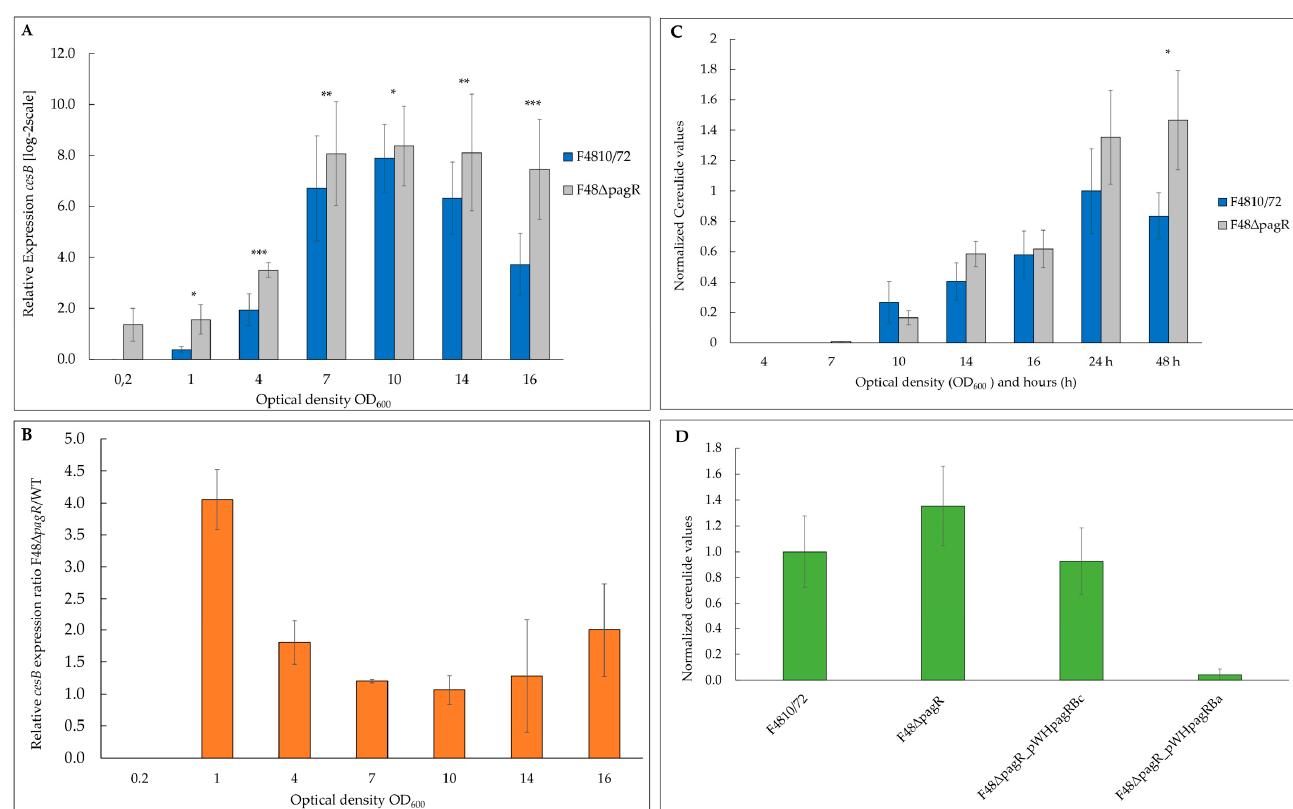
Figure 6. PagRBc represses cereulide toxin synthesis. The emetic reference strain B. cereus F4810/72 (wt) and its isogenic F48 ∆ pagR mutant were grown in LB broth at 30 °C. Total RNA was extracted from B. cereus F4810/72 and F48 ∆ pagR , harvested at indicated optical densities. Gene expression of ces and amounts of the cereulide toxin was determined at the OD 600 as indicated. ( A ) The kinetics of ces transcription in F48 ∆ pagR and its wild-type parent were determined by qRT-PCR. Levels of ces expression were determined by qRT-PCR and normalized to 16S rrn levels of the same sample preparations. The expression level of ces gene obtained for the wild-type strain at an OD 600 of 0.2 (external calibrator sample) was set to 1 (R = 1) by default, and all other expression levels were compared relative to this condition using the REST method [41]. Data were calculated from at least two independent qPCR measurements from three independent biological replicates. Statistically significant differences between the strains are denoted as follows: * p < 0.01, ** p < 0.001, *** p < 0.0001. ( B ) Results of a comparative REST analysis of the relative cesB transcription levels of F48 ∆ pagR and the wild-type strain. The rrn -normalized cesB expression values in F48 ∆ pagR are depicted as log-2 ratios relative to the normalized cesB expression values of the wild-type strain at the same optical densities. Statistically significant differences in the cesB mRNA levels between the strains are indicated as denoted in ( A ). ( C , D ) The amount of cereulide in F48 ∆ pagR , the wild-type strain and the pagRBc complementation strains was determined by UPLC-MS/MS. ( C ) Samples from F48 ∆ pagR and the wild-type strain were analyzed at the OD 600 s and hours indicated. ( D ) In addition, cereulide was determined in F48 ∆ pagR complemented in trans with pagRBc (F48 ∆ pagR _pWH pagRBc ) and pagRBa (F48 ∆ pagR_ pWH pagRBa ), respectively; using a xylose-inducible promoter. Cereulide levels were calculated relative to the cereulide amount of the wild-type strain F4810/72 at 24 h. Samples were taken from three independent experiments shown as averages with standard deviations.